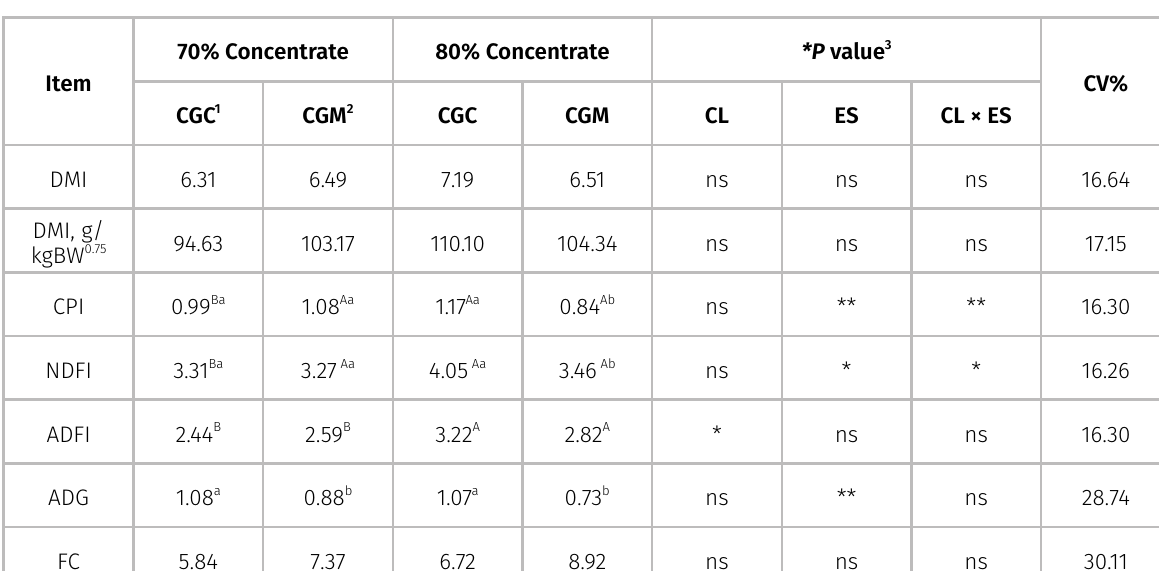
Table II. Intakes (kg/day), average daily gain – ADG (kg/day), and feed conversion - FC of Nellore heifers fed two concentrate levels and energy